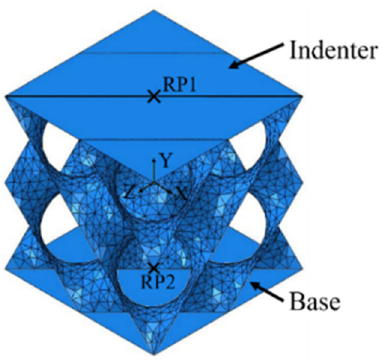
Figure 5. Assembly diagram of the D structure and rigid surface.